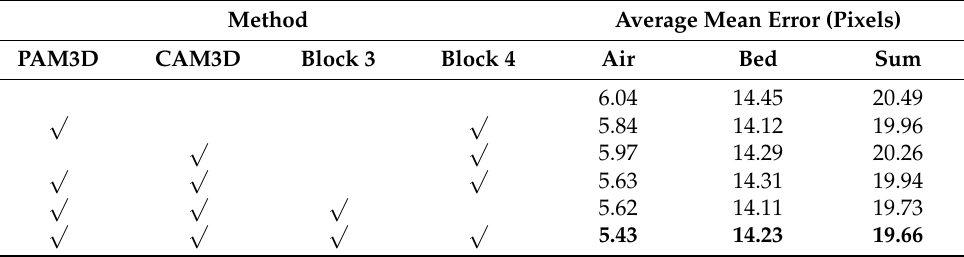
Table 5. Performance of attention modules in different positions. The symbol of “ means which method is used.